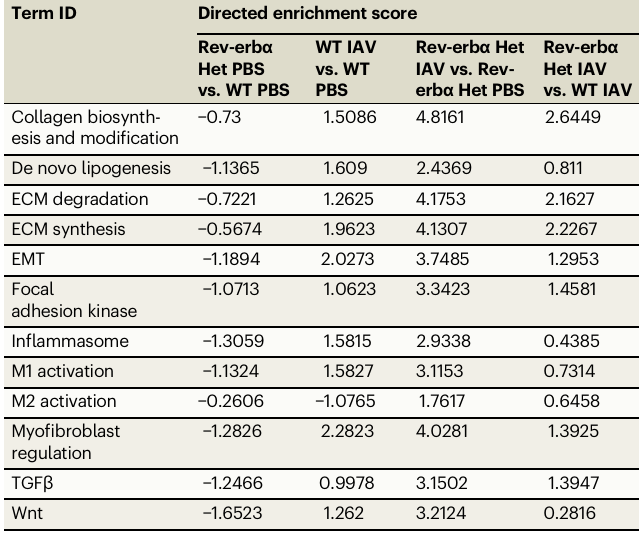
Table 2 | Dysregulated pathways after IAV infection in both WT and Rev-erb α Het mice Term ID Directed enrichment score Rev-erb α Het